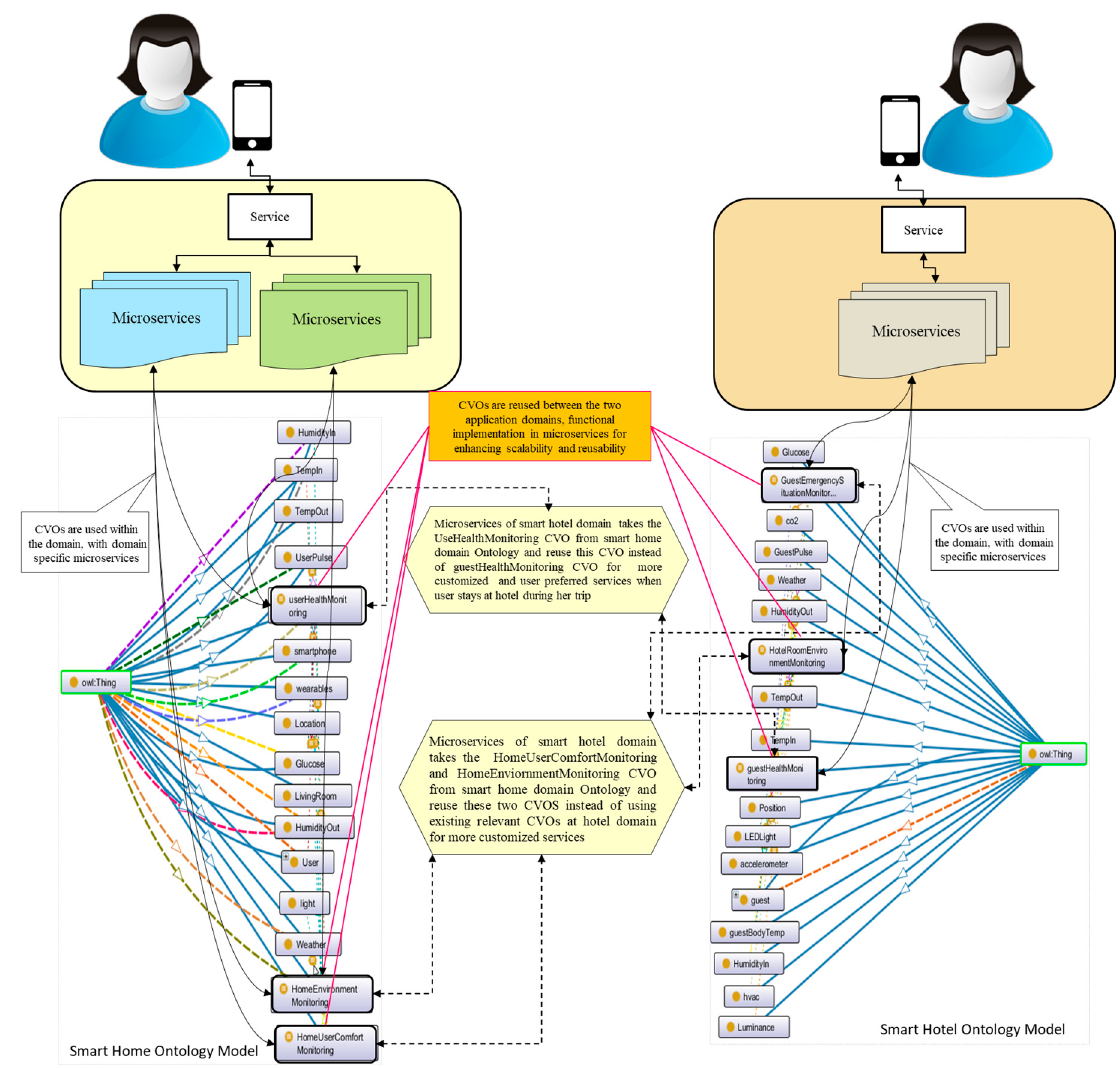
Figure 5. Microservices with relevant CVOs and VOs in ontology for smart home and smart hotel as